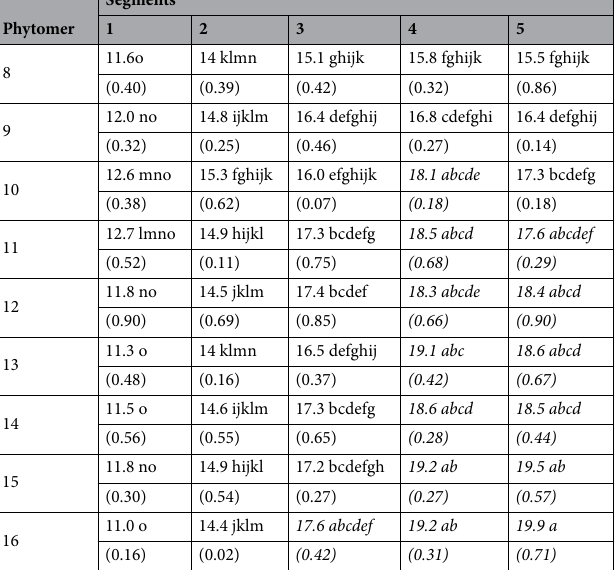
Table 5. Crude protein (CP) percentage along the blade of Napier elephant grass leaves. Means followed by the same letters are not different ( P > 0.05). Values in parentheses correspond to the standard error of the mean. The highlights in italics indicate similar